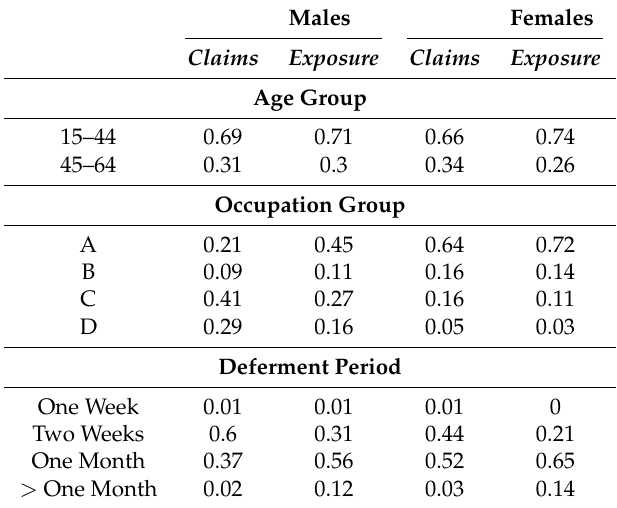
Table 2. Proportion of claims and exposure by Age Group, Occupation Class and Deferment Period classification from 1986 to 2001.